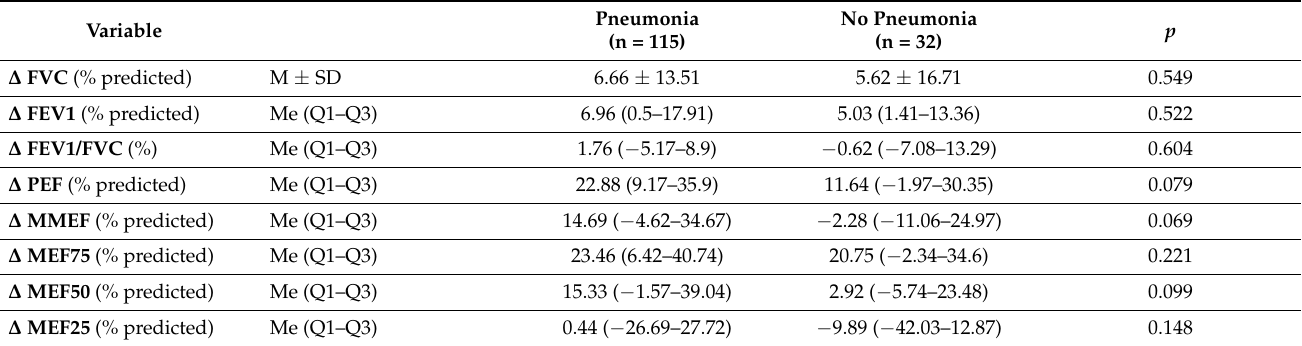
Table 6. Relationships between the difference in spirometric results before and after rehabilitation and the presence of COVID-19 pneumonia.